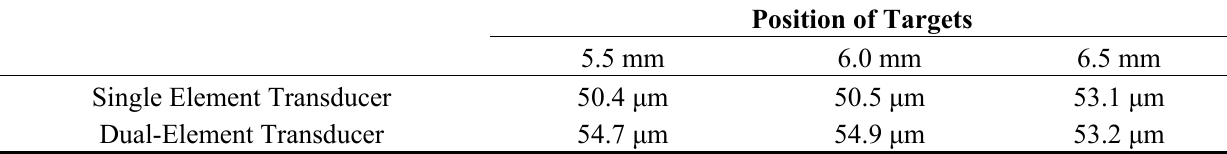
Table 3. Comparison of −20 dB axial beamwidth between single and dual-element transducers in Figure 6.